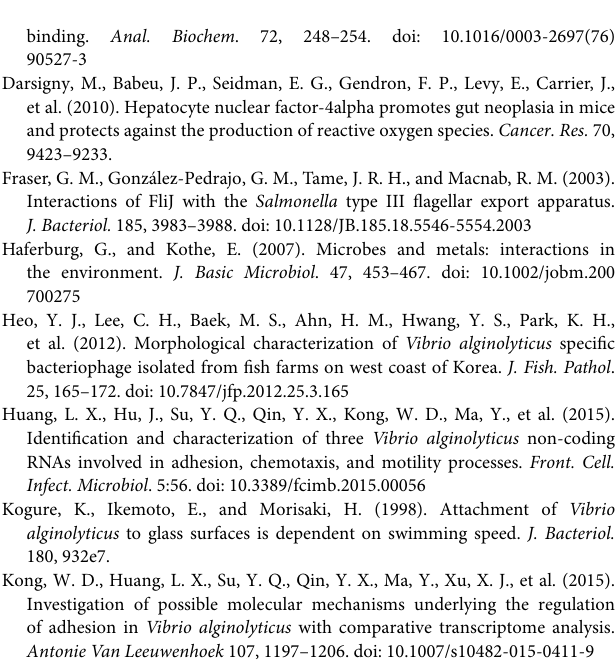
Figure S1 | Expression stability assay of the references genes. GeNorm analysis uses the delta Cq method, with the PCR efficiencies based on a dilution series of pooled cDNA samples, and the internal control gene-stability measureM is defined as the average pairwise variation of a special gene with all other control genes. Genes have the most stable expression are marked with the lowest M -values, and then exclude the gene with the highest M -value step by step to gain a combination of two constitutively expressed housekeeping genes that have the most stable expression in the tested samples. Figure S2 | The overall scheme for genes involved in the flagellar assembly pathway that were significantly affected by Cu stress. Green and red indicate decreased and increased expression, respectively. Figure S3 | The overall scheme for genes involved in the flagellar assembly pathway that were significantly affected by Pb stress. Green and red indicate decreased and increased expression, respectively. Figure S4 | The overall scheme for genes involved in the flagellar assembly pathway that were significantly affected by Hg stress. Green and red indicate decreased and increased expression, respectively. Figure S5 | The overall scheme for genes involved in the flagellar assembly pathway that were significantly affected by low pH stress. Green and red indicate decreased and increased expression,